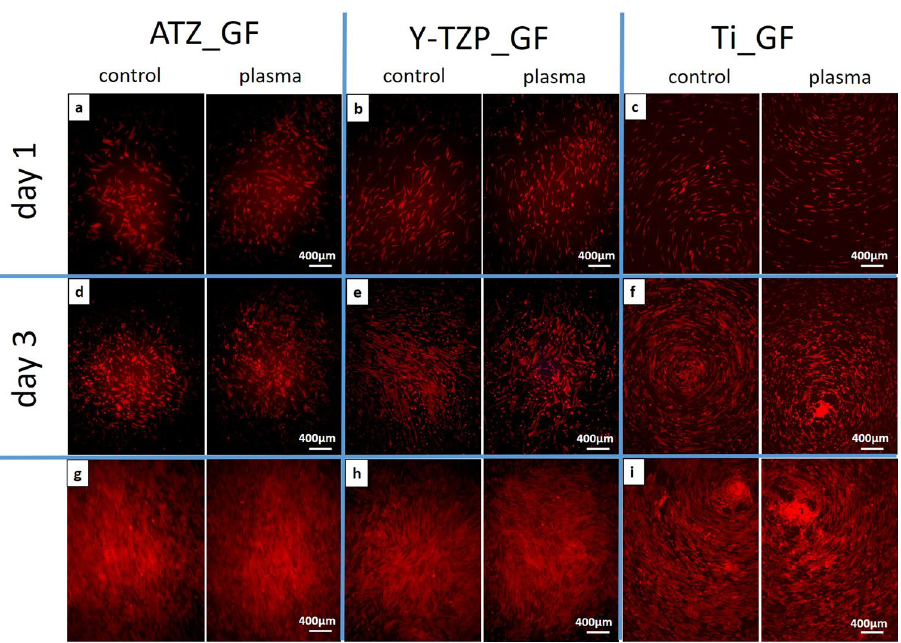
Figure 9. Immunofluorescence of phalloidin-labelled actin (red fluorescence) in fibroblasts cultivated for 1, 3 or 7 days on plasma-functionalized and control